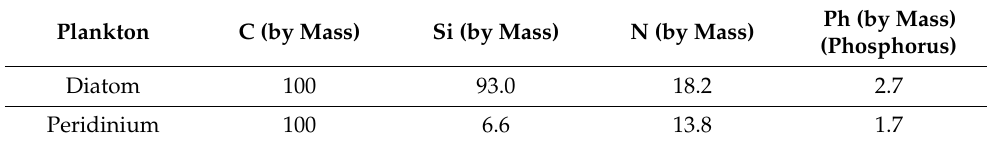
Ph (by Mass) (Phosphorus)